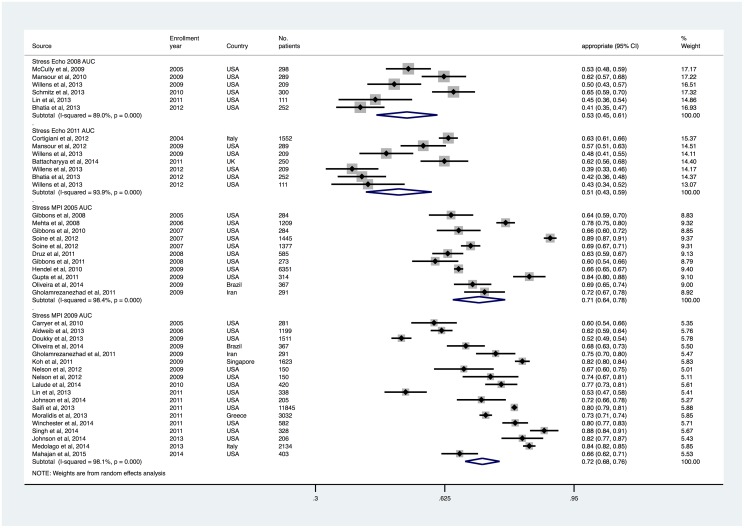
Appropriate Use Rates of Stress Echocardiography and MPI, Sorted by Patient Enrollment Year.